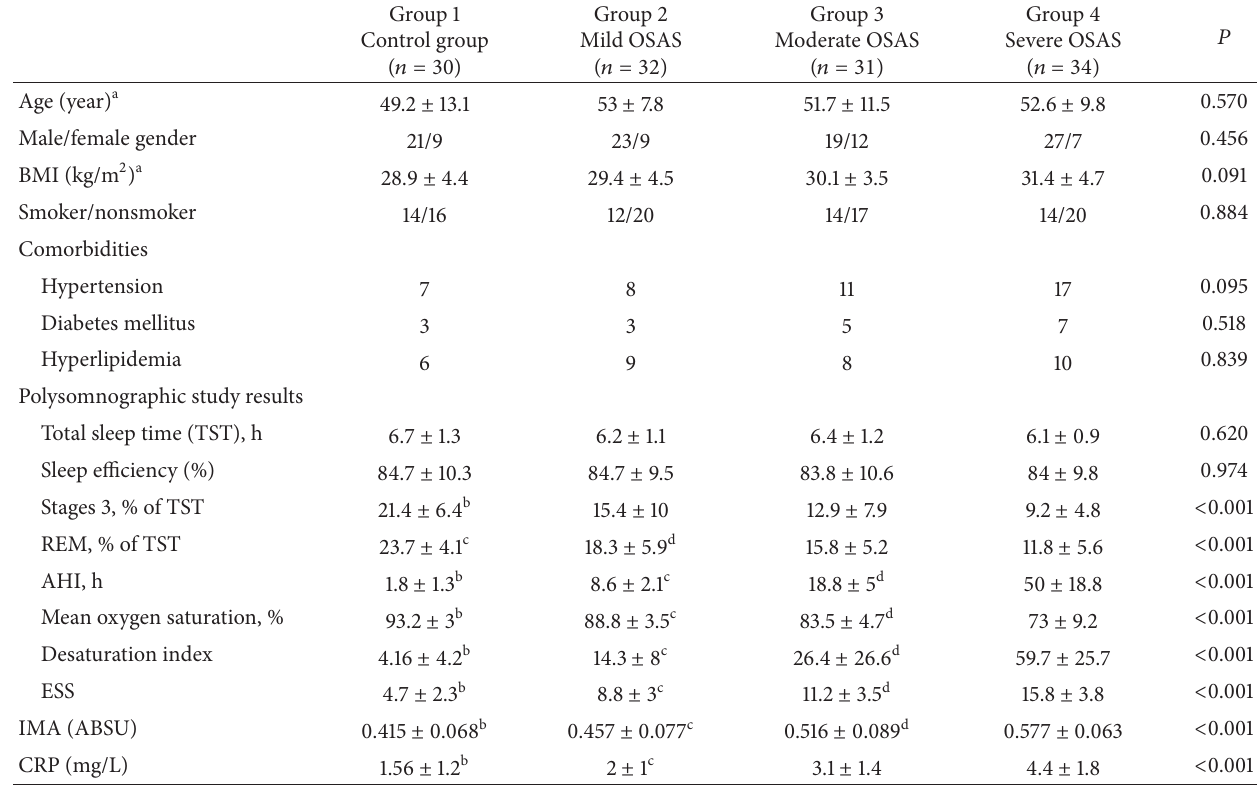
Table 1: Demographic, clinical characteristics and laboratory values of the study group.